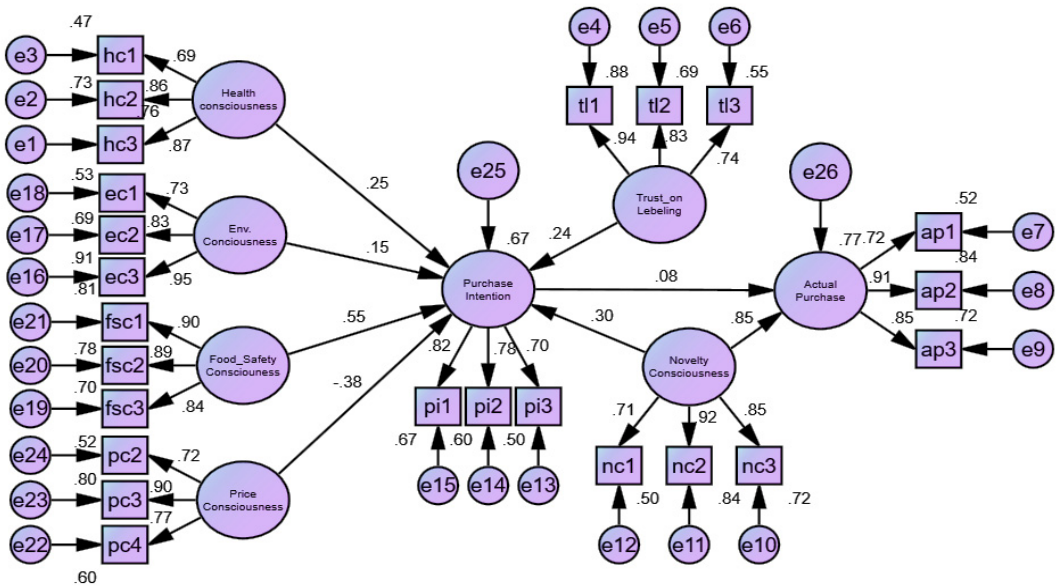
Table 4. Structural Model and Hypothesis Testing